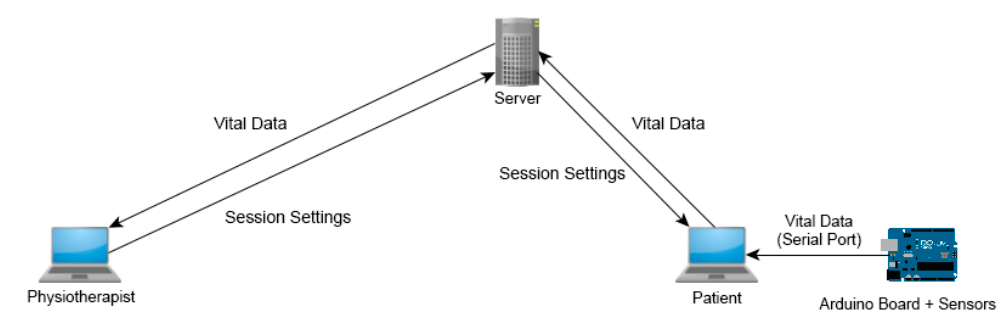
Figure 5. Data Transmission Diagram.